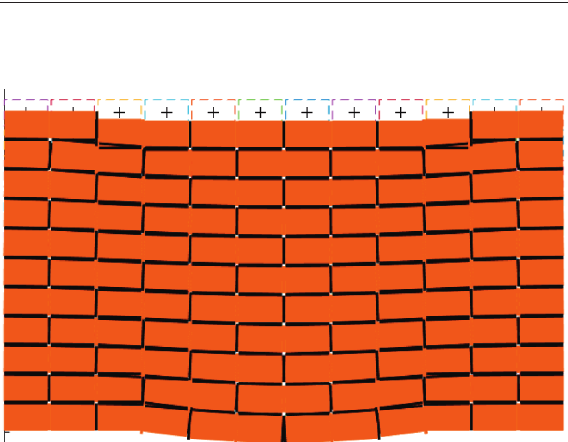
Figure 10: Deformed configuration close to the end of the nu- merical deep beam tests ( P �